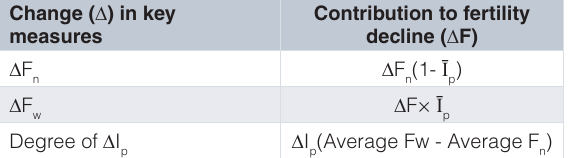
Contribution to fertility decline ( ∆